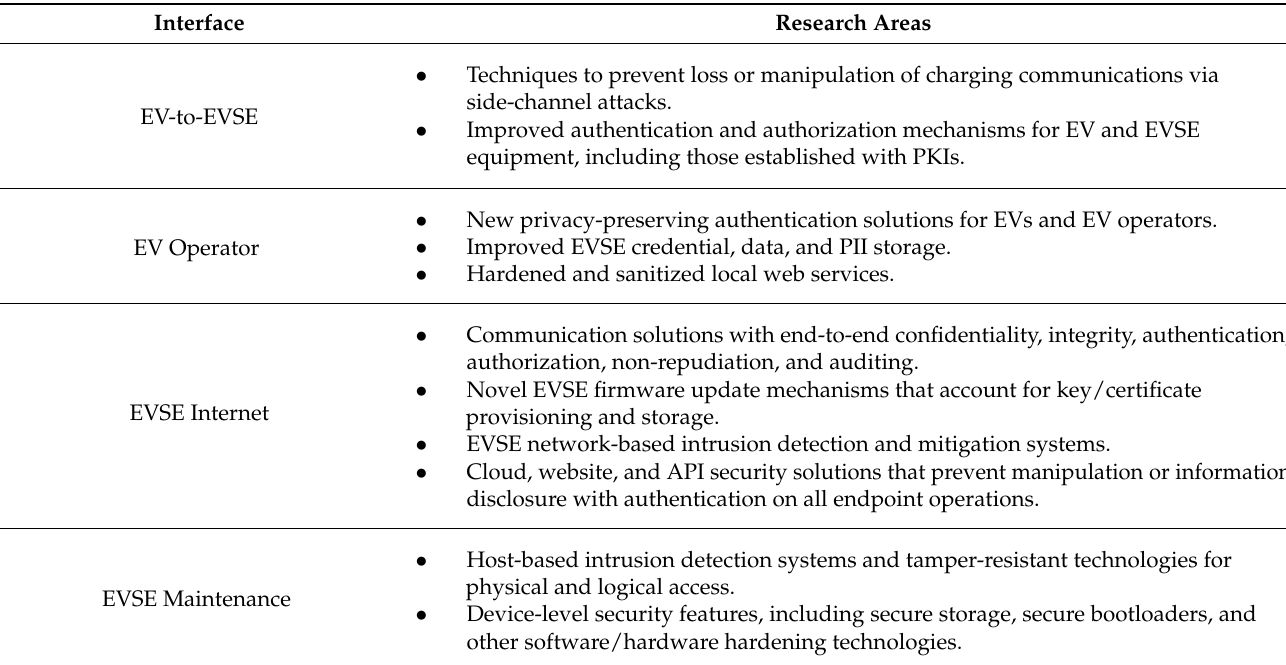
Table 7. Major Cybersecurity research needs for EVSE